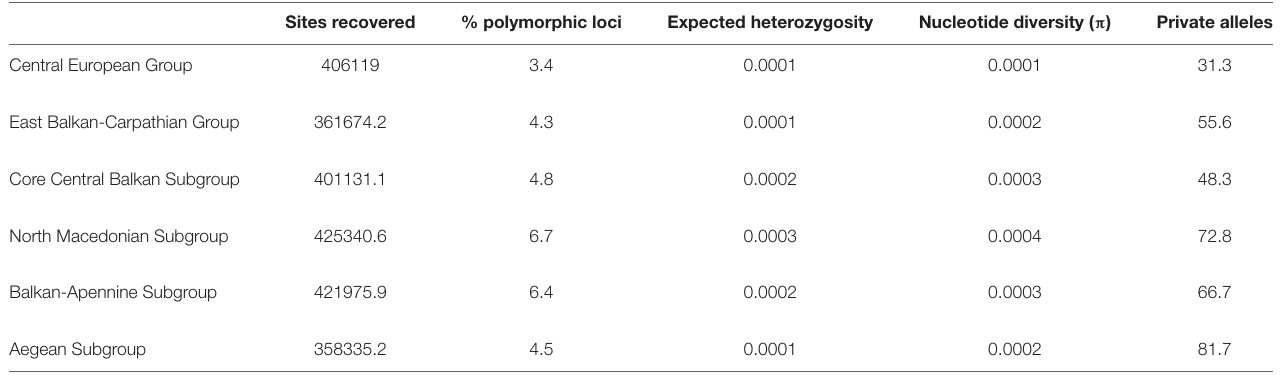
TABLE 1 | Descriptors of the groups of populations of Aurinia saxatilis identified with restriction-site associated DNA sequencing (RADseq)